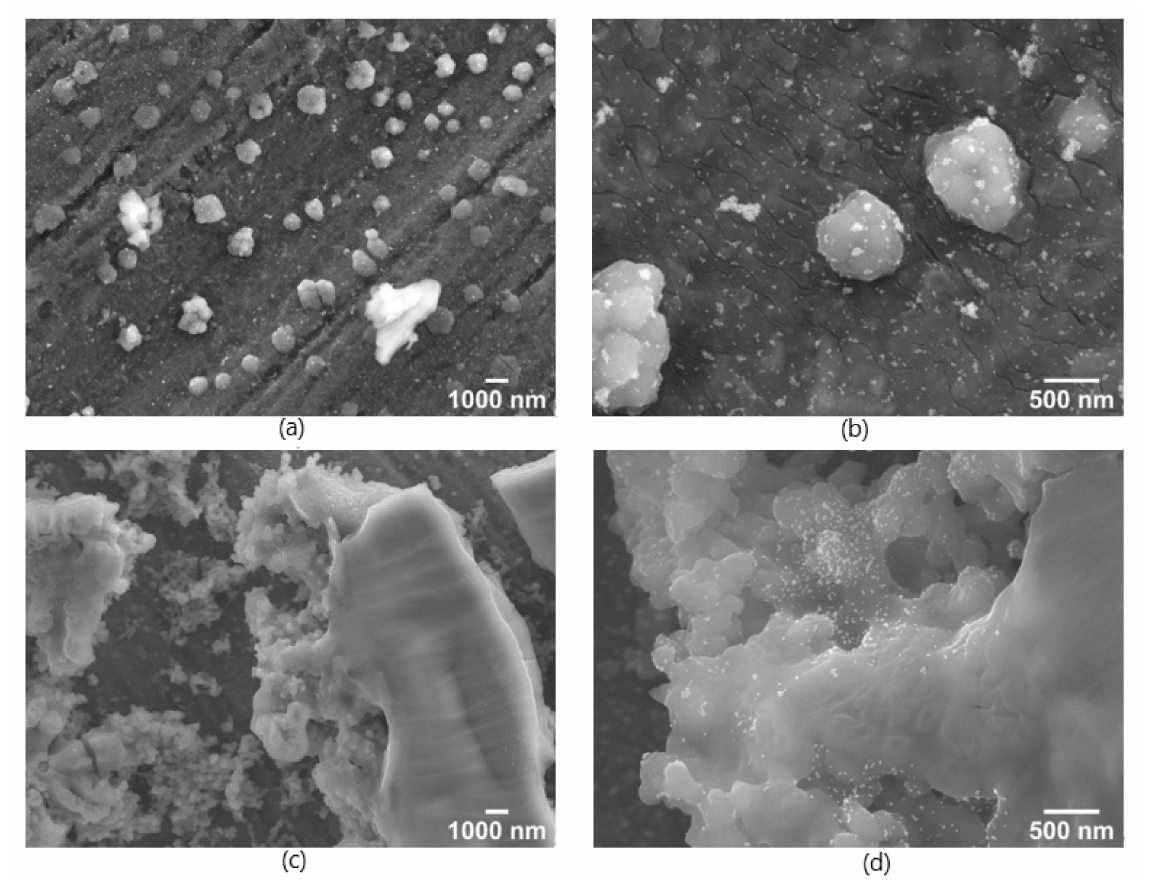
Figure 2. SEM-images of SERS-substrates coated with a solution of 1% ( a , b ) and 10% ( c , d ) TTIP and dried for 24 h under ambient conditions. Afterwards they were coated with AuNPs. Left side shows a 5000 × magnification ( a , c ) and the right side a 25,000 × magnification ( b , d ) with a working distance (WD) 4 mm and 10 kV acceleration